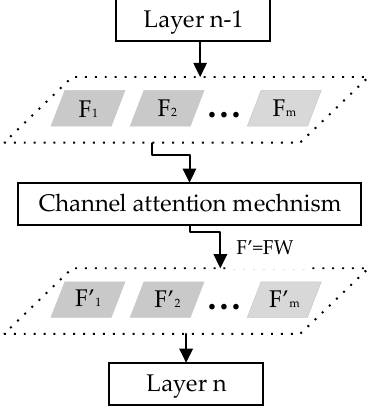
Figure 3. Channel attention mechanism.